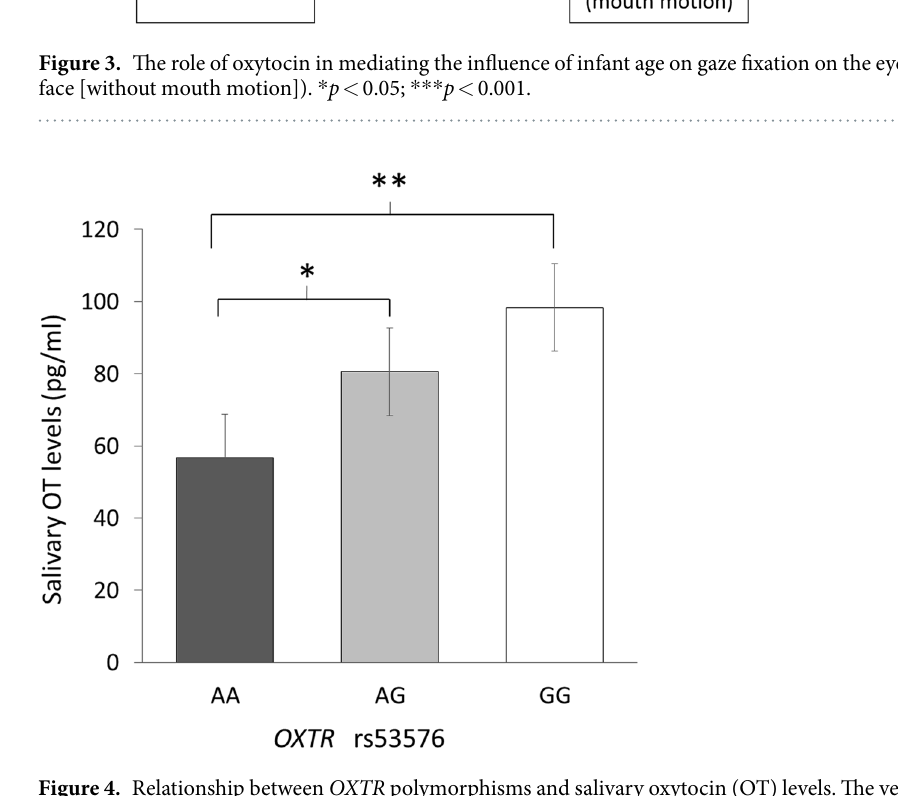
Figure 4. Relationship between OXTR polymorphisms and salivary oxytocin (OT) levels. The vertical axis indicates salivary OT levels (pg/ml). The horizontal axis indicates the OXTR genotypes. * p < 0.05; ** p <